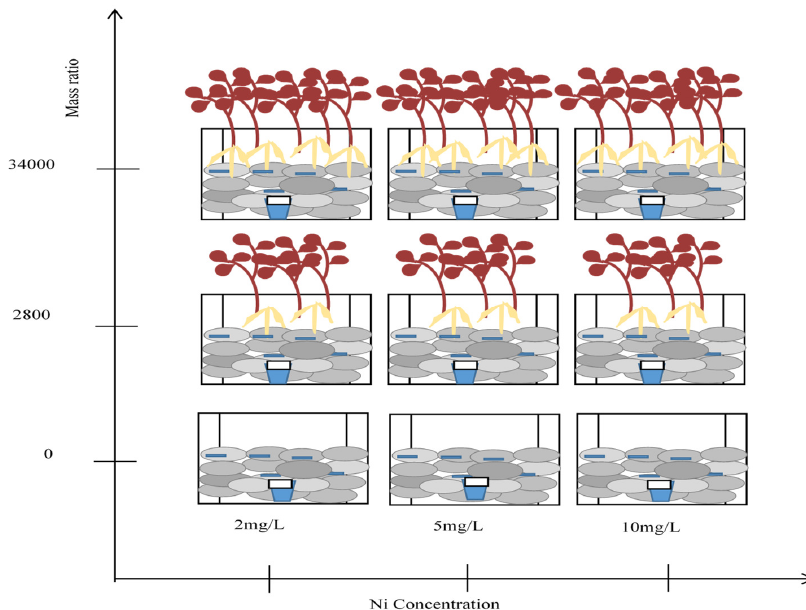
Fig. 1. Plants arrangement in the aquarium according to the mass